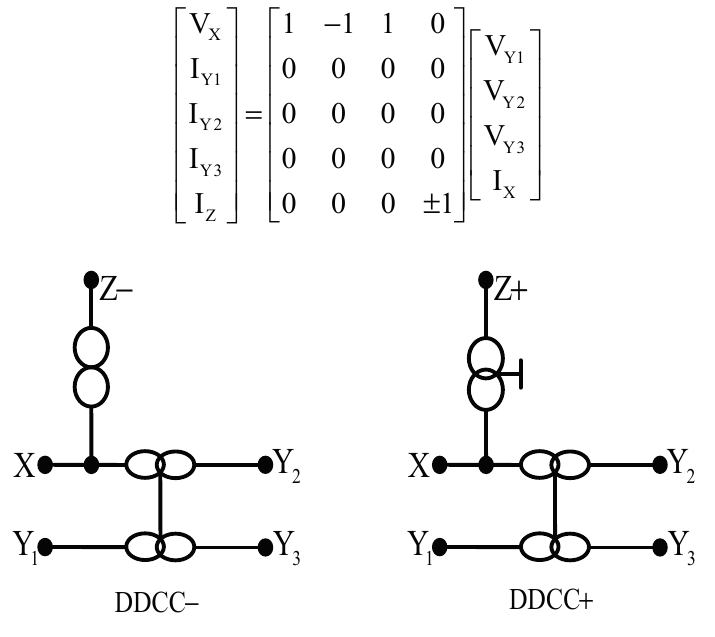
Figure 1. The symbolic pathological representations of